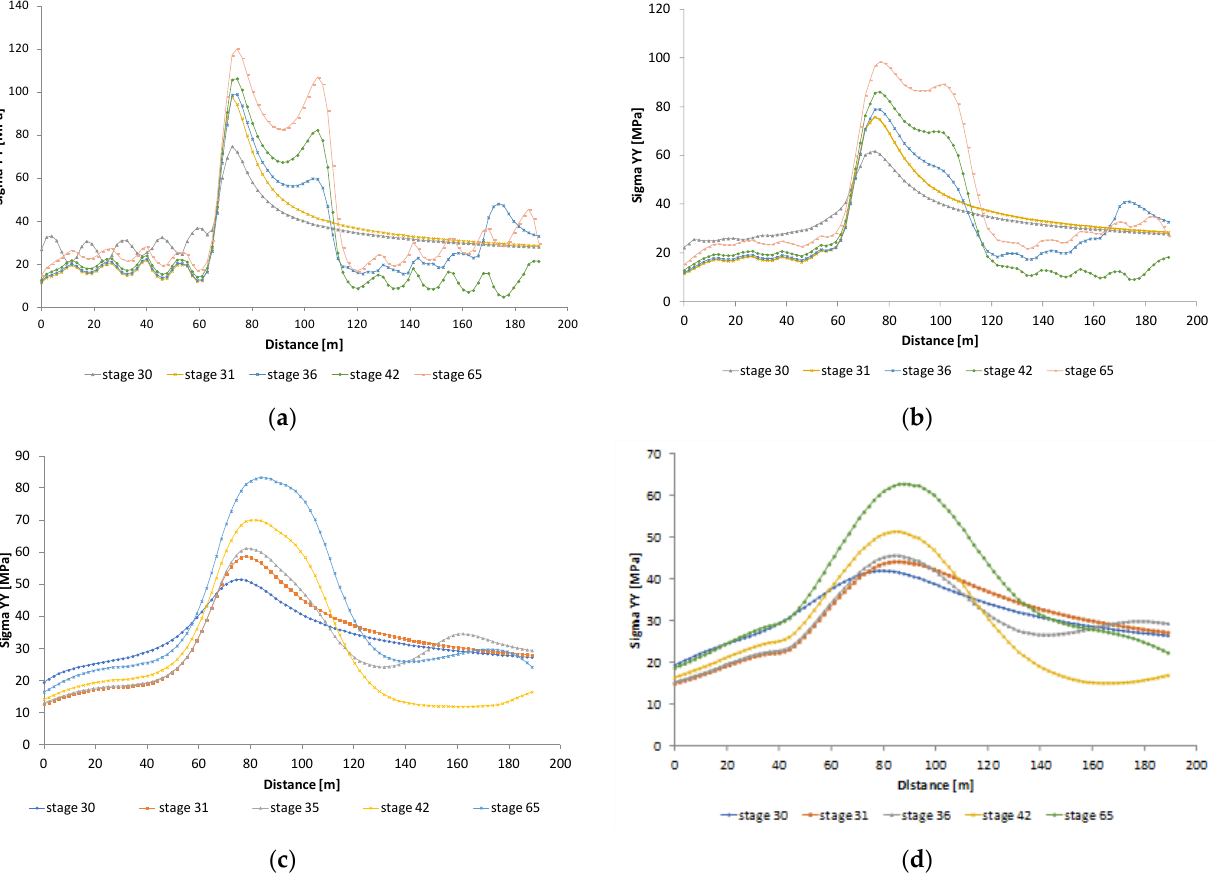
Figure 13. Vertical stress σ y in the roof, for vertical distances of: ( a ) — 5 m, ( b ) — 10 m, ( c ) — 20 m and ( d ) — 40 m above the remnant.